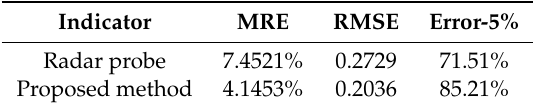
Figure 20. Absolute and relative errors of values obtained using the proposed method and the radar probe. Table 2. Error comparison of two measurement